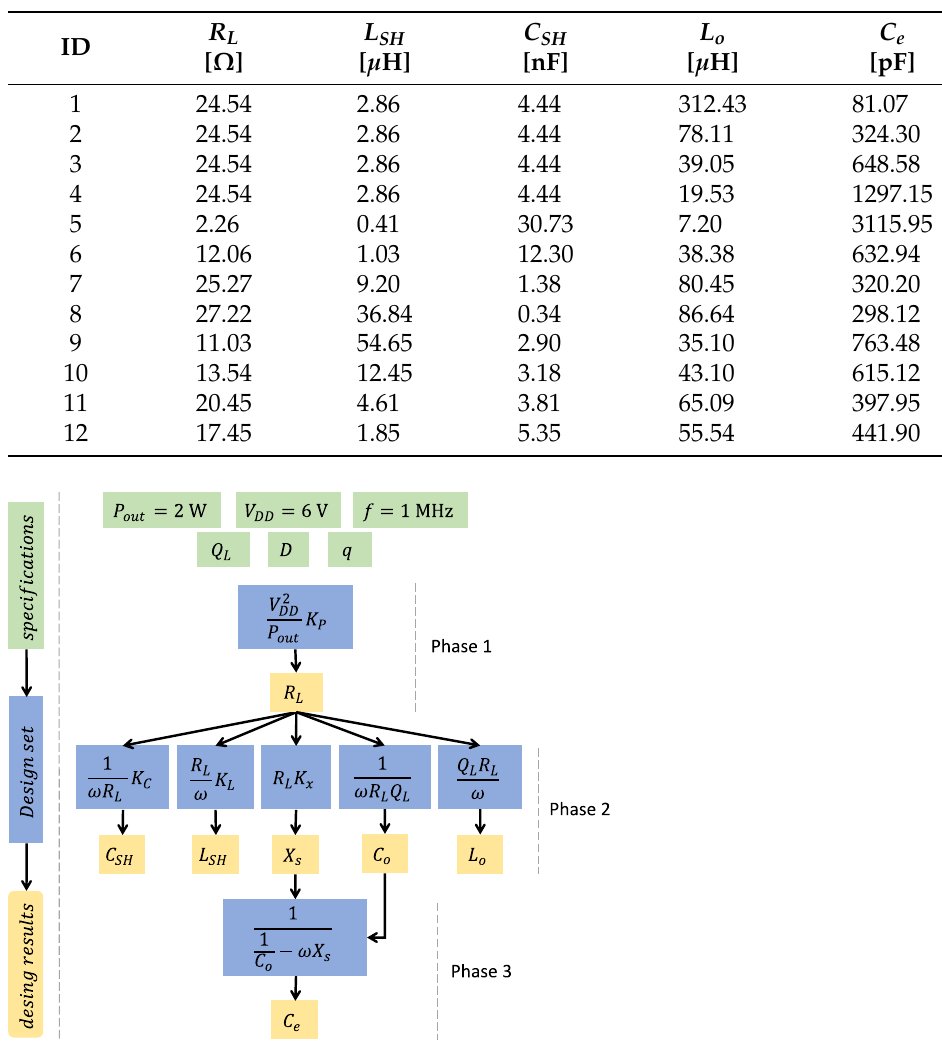
Figure 8. Phases to find the unknown circuit